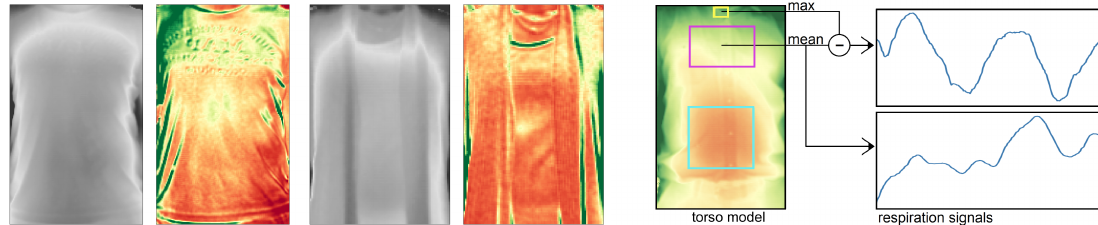
Figure 5. Left : Torso surface (left images) and variance of a 12 s time window (right images) of two persons. Red: Low variance; Green: high variance. The throat area shows low variance while the remaining area highly is influenced by clothing. Right : The estimation of the respiration signal uses defined areas in the torso window. For the chest region, the result ( top right ) is a clean respiration signal when subtracting the maximum depth measure for a small region around the throat and the mean depth measurement over the chest region. In contrast, the mean depth measurements over the chest alone are highly influenced by motion artifacts ( bottom right